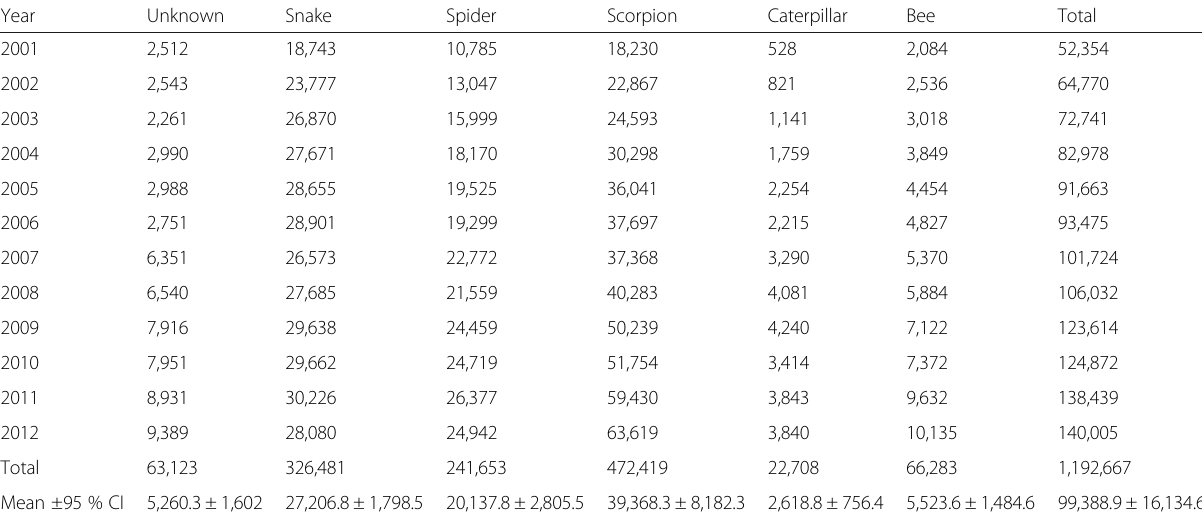
Table 1 Yearly number of envenomations by terrestrial venomous animals in Brazil, 2001-2012 Year Unknown Snake Spider Scorpion